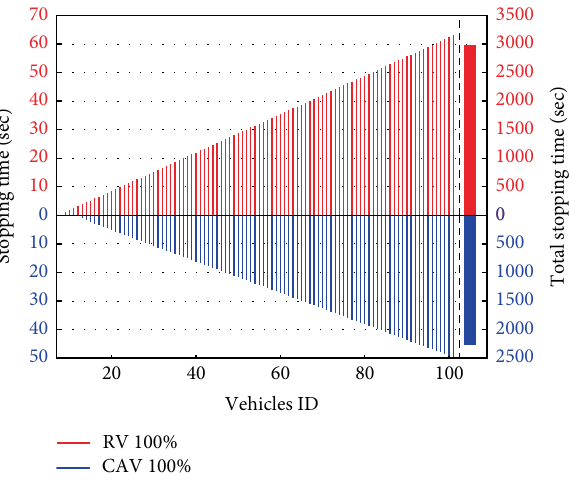
Figure 9: Vehicles’ stopping time in two